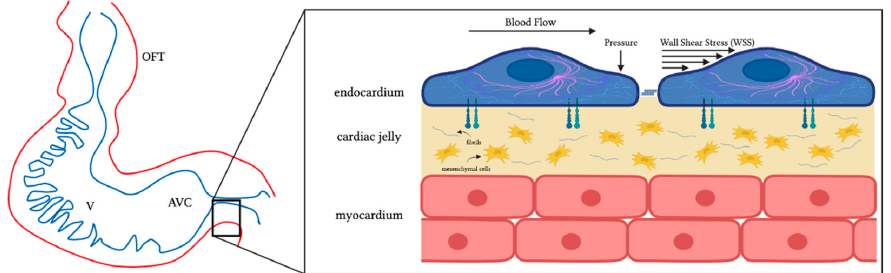
cells line the interior of the heart wall, forming an endocardium layer. Cells in the endocardium are in contact with blood and directly exposed to blood flow stresses, wall shear stress and blood pressure. Stresses and deformations are sensed through ion channels, the cell cytoskeleton, cell–cell junctions, and cell adhesion proteins among other mechanisms. Myocardial muscle cells line the exterior of the cardiac wall forming a myocardium layer. In between the endocardium and myocardium, there is a cardiac jelly layer. In the cushions, the cardiac jelly layer has mesenchymal cells. While the myocardium is not in direct contact with blood, it senses stresses and is deformed due to its contraction–relaxation behavior and its interaction with blood flow. OFT: outflow tract; V: ventricle; AVC: atrioventricular canal. Created with BioRender.com (accessed on 24 July